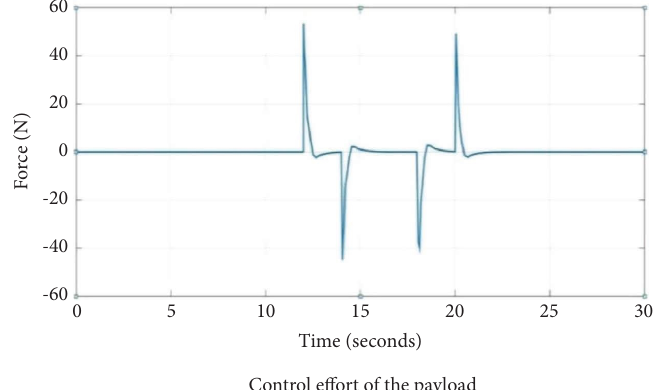
Figure 6: System exerted efort with the frst input signal using hybrid controllers.